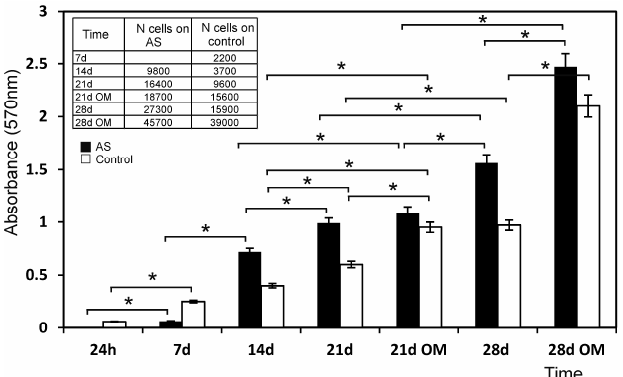
Figure 4. Proliferation of the cells seeded on the AS ceramic compared to plastic, used as the control in the MTT assay. * denotes significance at p < 0.05 between these samples.